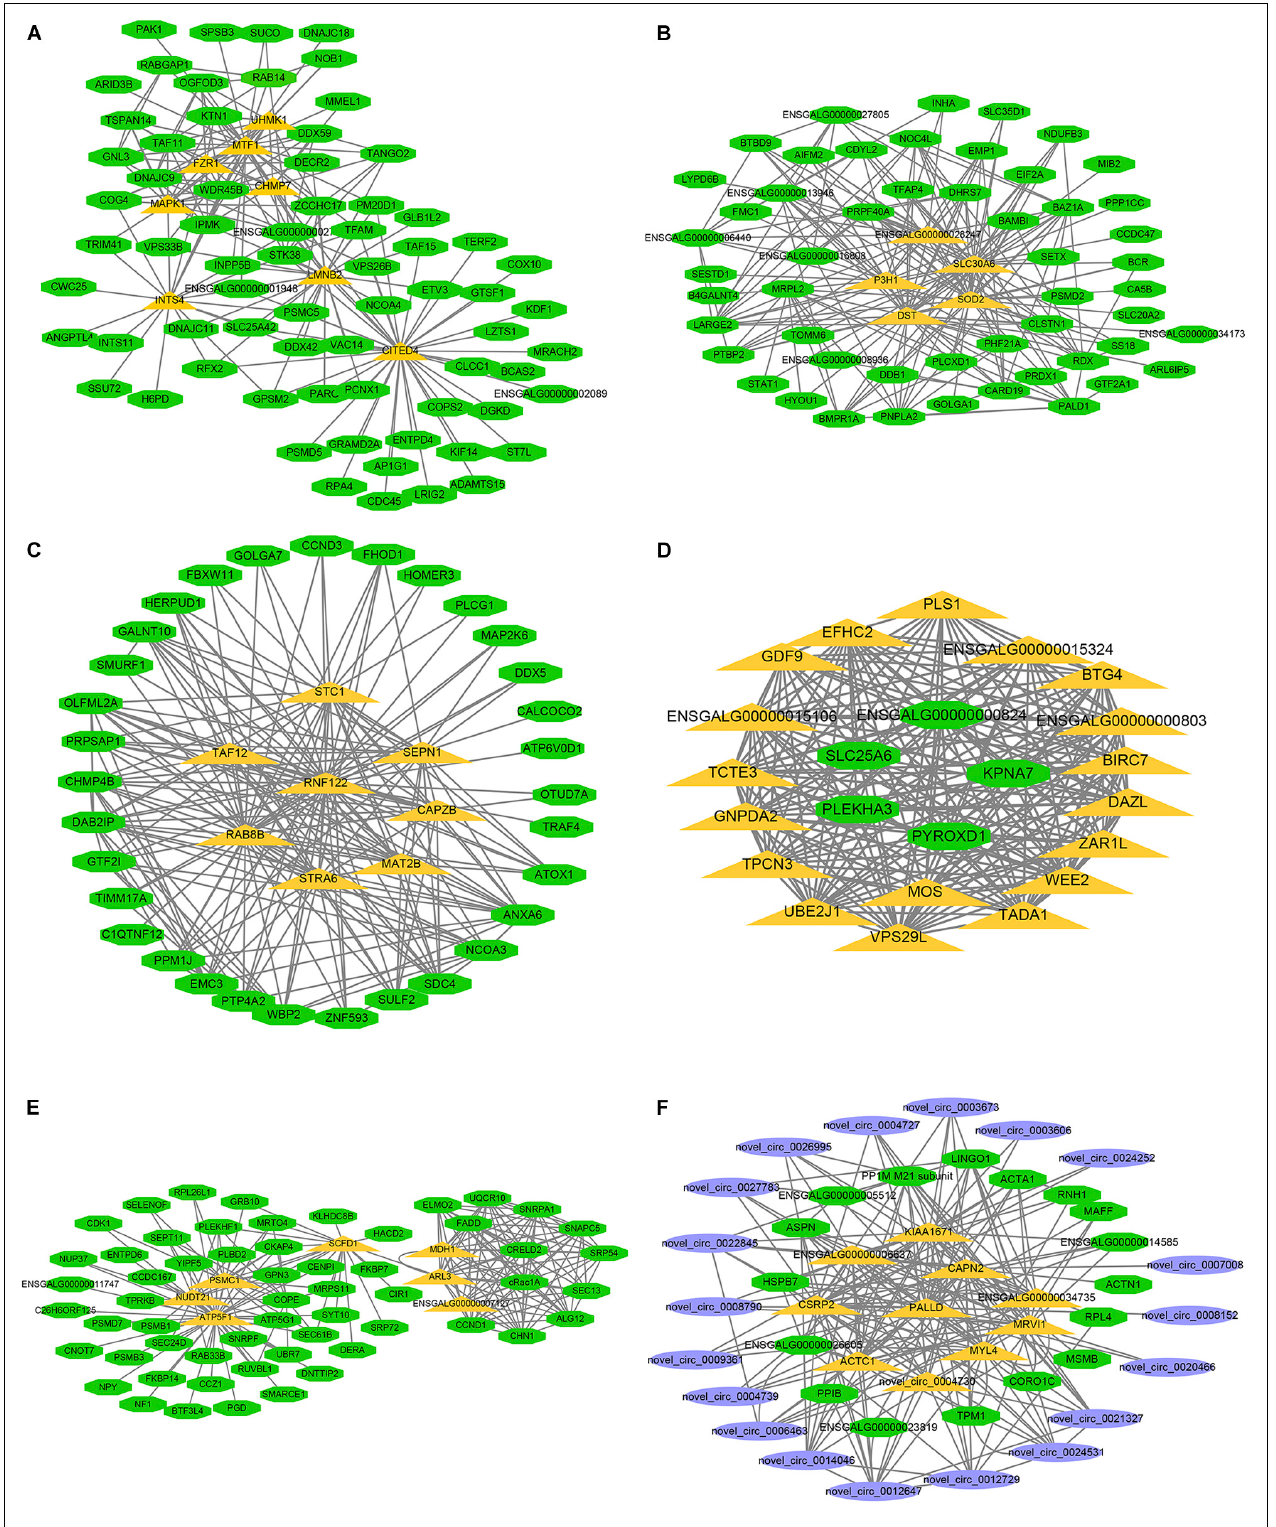
FIGURE 10 | Visualization of hub genes in specific module. Network of (A–F) represent top hub genes in module darksegreen4, brown4, darkred, lightgreen, ivory, and skyblue, respectively. Green nodes represent protein-coding gene, blue nodes represent circRNA, orange nodes represent highly connected intramodular hub genes with edge number ≥